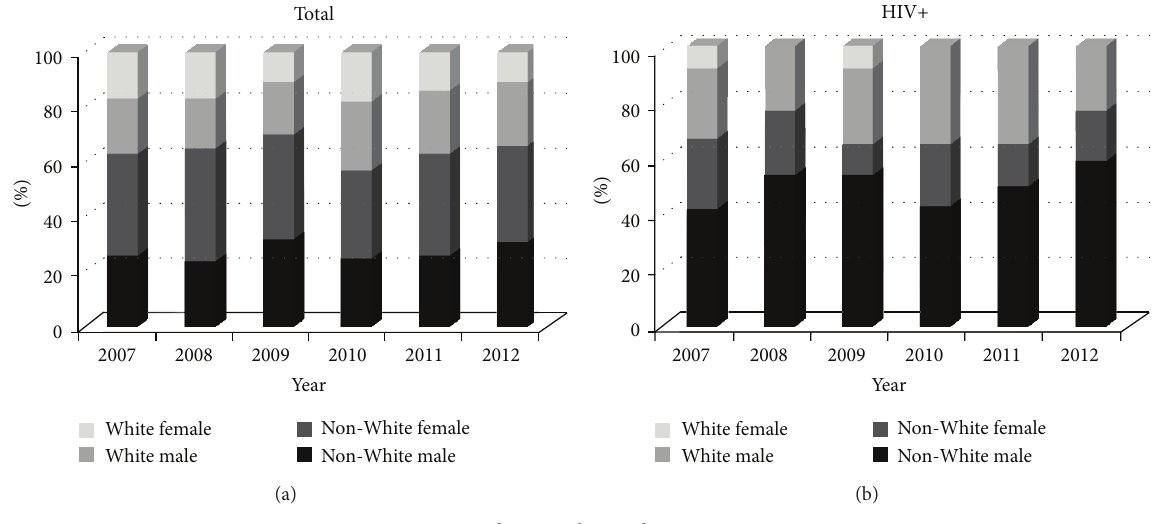
Figure 1: Race-Gender Distribution by year, AL,